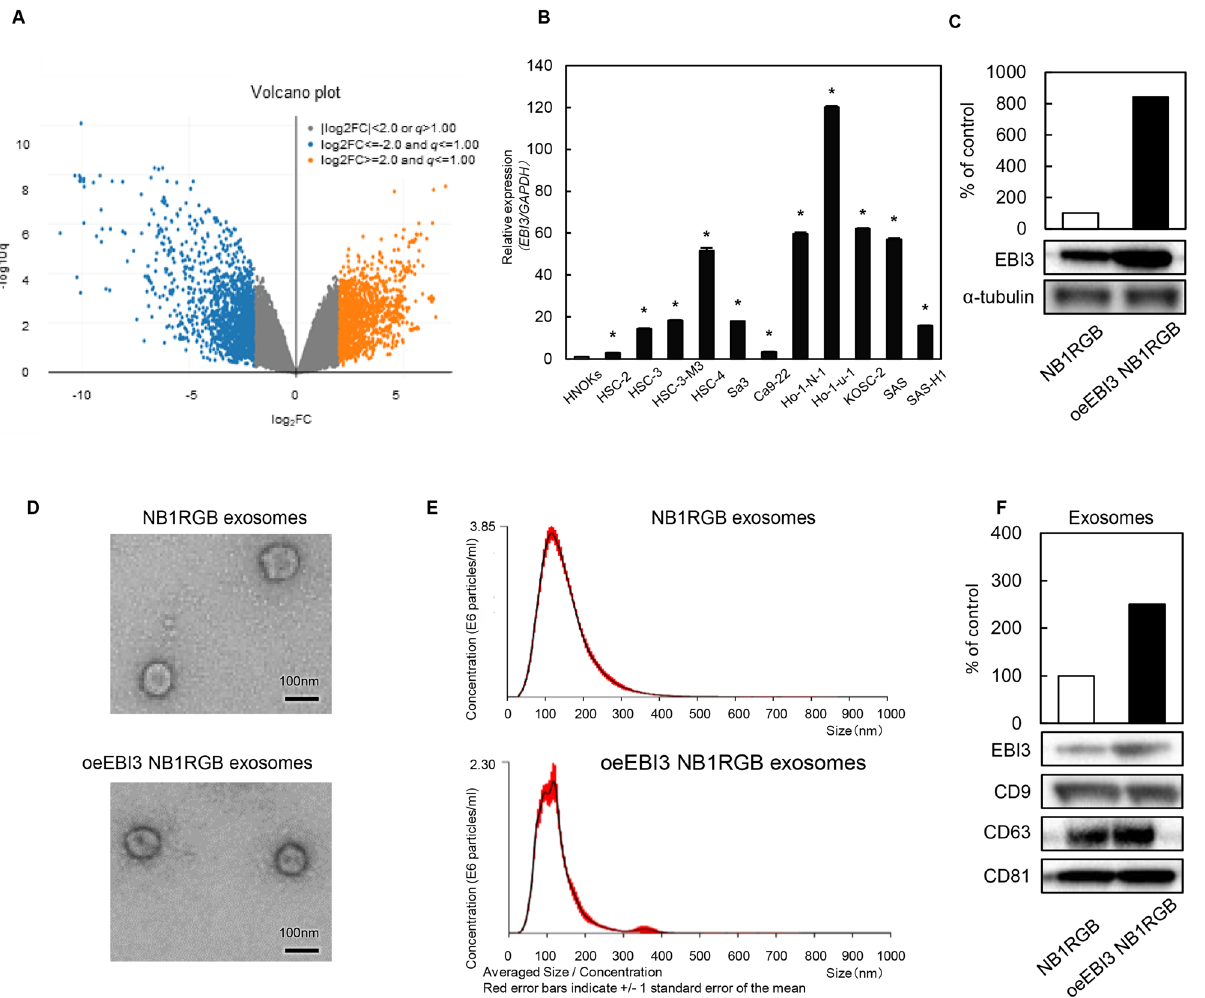
Figure 1. Expression of EBI3 in OSCC, normal cells and exosomes. ( A ) Volcano plots of significant genes with P < 0.01 and more than a two-fold change or less than a 0.5-fold change expressed in 1536 upregulated genes and 3381 downregulated genes. The x-coordinate represents the (log 2 ) fold-change (FC) and y represents the t-statistic or − log 10 q of the P value. ( B ) A qPCR analysis of EBI3 transcripts in HNOKs and OSCC cell lines. The levels of EBI3 transcripts were normalized to the expression of GAPDH . Data are expressed as ratios of EBI3 to GAPDH . Data are presented as means ± SD (n = 3). * P < 0.05. ( C ) Increased EBI3 in transfected NB1RGB cells was evident when compared to the mock cells. Densitometric EBI3 protein data were normalized to α-tubulin protein levels. ( D ) Electron micrograph of NB1RGB exosomes and oeEBI3 NB1RGB exosomes. ( E ) Size distribution of NB1RGB exosomes and oeEBI3 NB1RGB exosomes measured by NTA peaking at 100 nm diameter. ( F ) EBI3 Western blots of the corresponding exosomes. Note that EBI3-transfected NB1RGB cells released greater amounts of EBI3-expressing exosomes than control cells. CD9, CD63 and CD81 expressions were analyzed as an exosomal